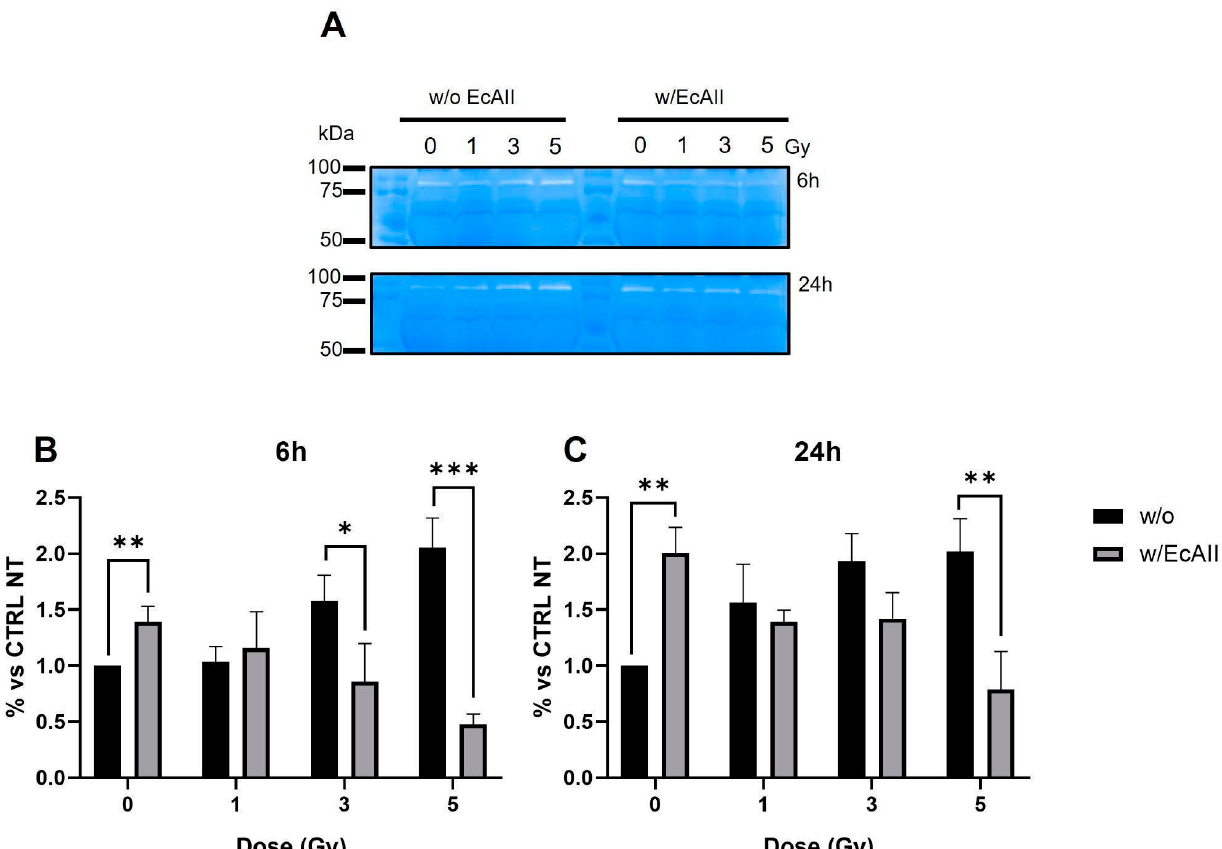
Figure 5. MMP-9 activity with gelatin zymography for Caco-2 cells exposed to different doses of X rays (0, 1, 3 and 5 Gy), without (w/o) or with 1 U/mL EcAII (w/EcAII). ( A ) Representative images of gelatin zymography with identification of MMP-9 bands. Changes in MMP-9 gelatinolytic activity were expressed relative to the unirradiated and untreated control at each time point (% vs. CTRL NT) and quantified for samples without (w/o) of EcAII (black bar) and with EcAII (gray bar): ( B ) 6 h irradiation; ( C ) 24 h after irradiation. * p < 0.05, ** p < 0.01, *** p < 0.001.